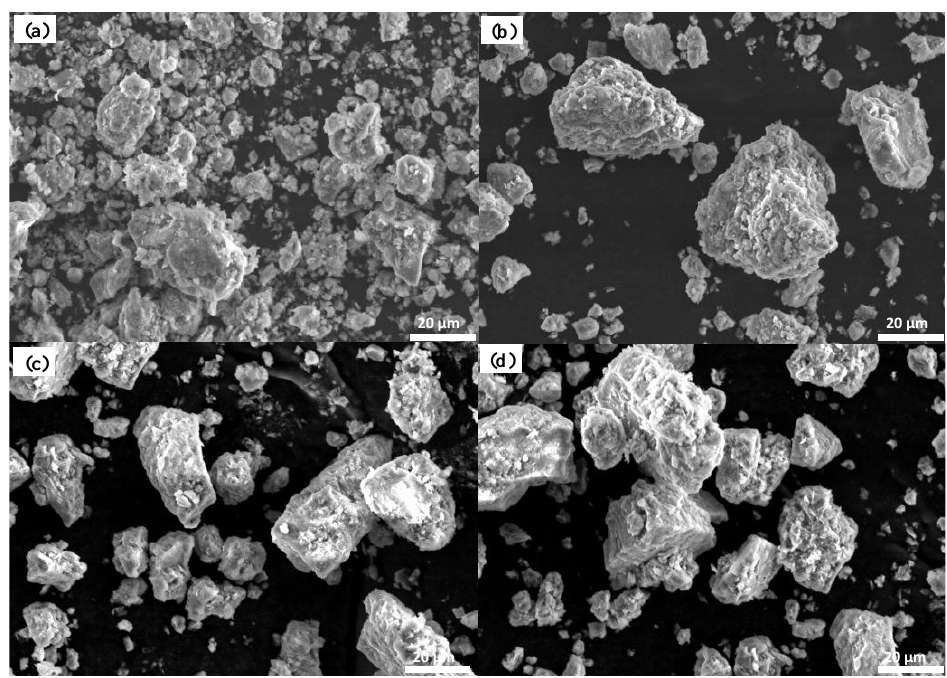
Figure 4. SEM micrographs of: ( a ) wet sieved bentonite; ( b ) 2 wt.%, ( c ) 4 wt.%, and ( d ) 6 wt.% of Na 2 CO 3 -modified samples. The scale bar on micrographs corresponds to 20 µm.